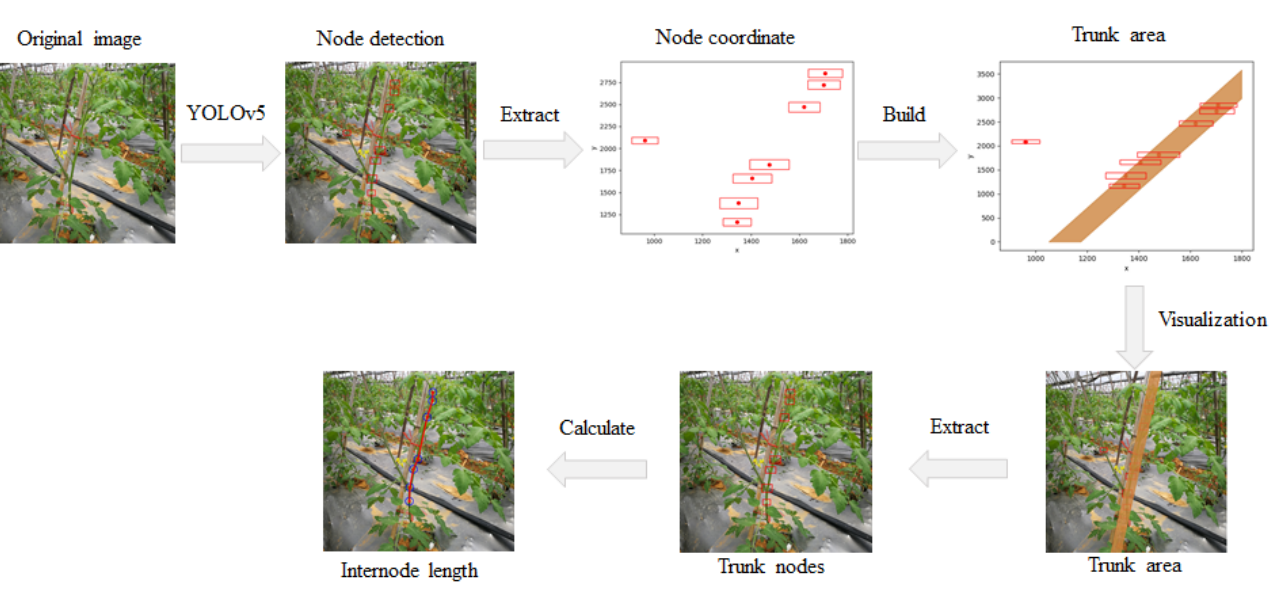
Figure 3. The overview of the complete pipeline for internode length estimation.